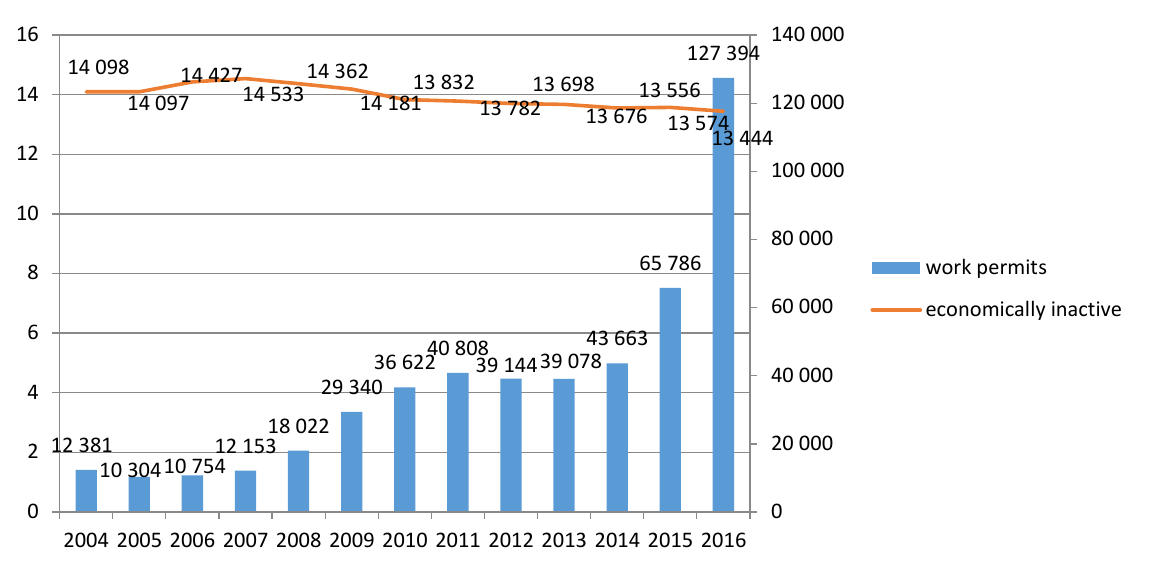
Figure 5. Work permits issued (right axis) and the economically inactive population in millions (left axis) in Poland, 2004–2016